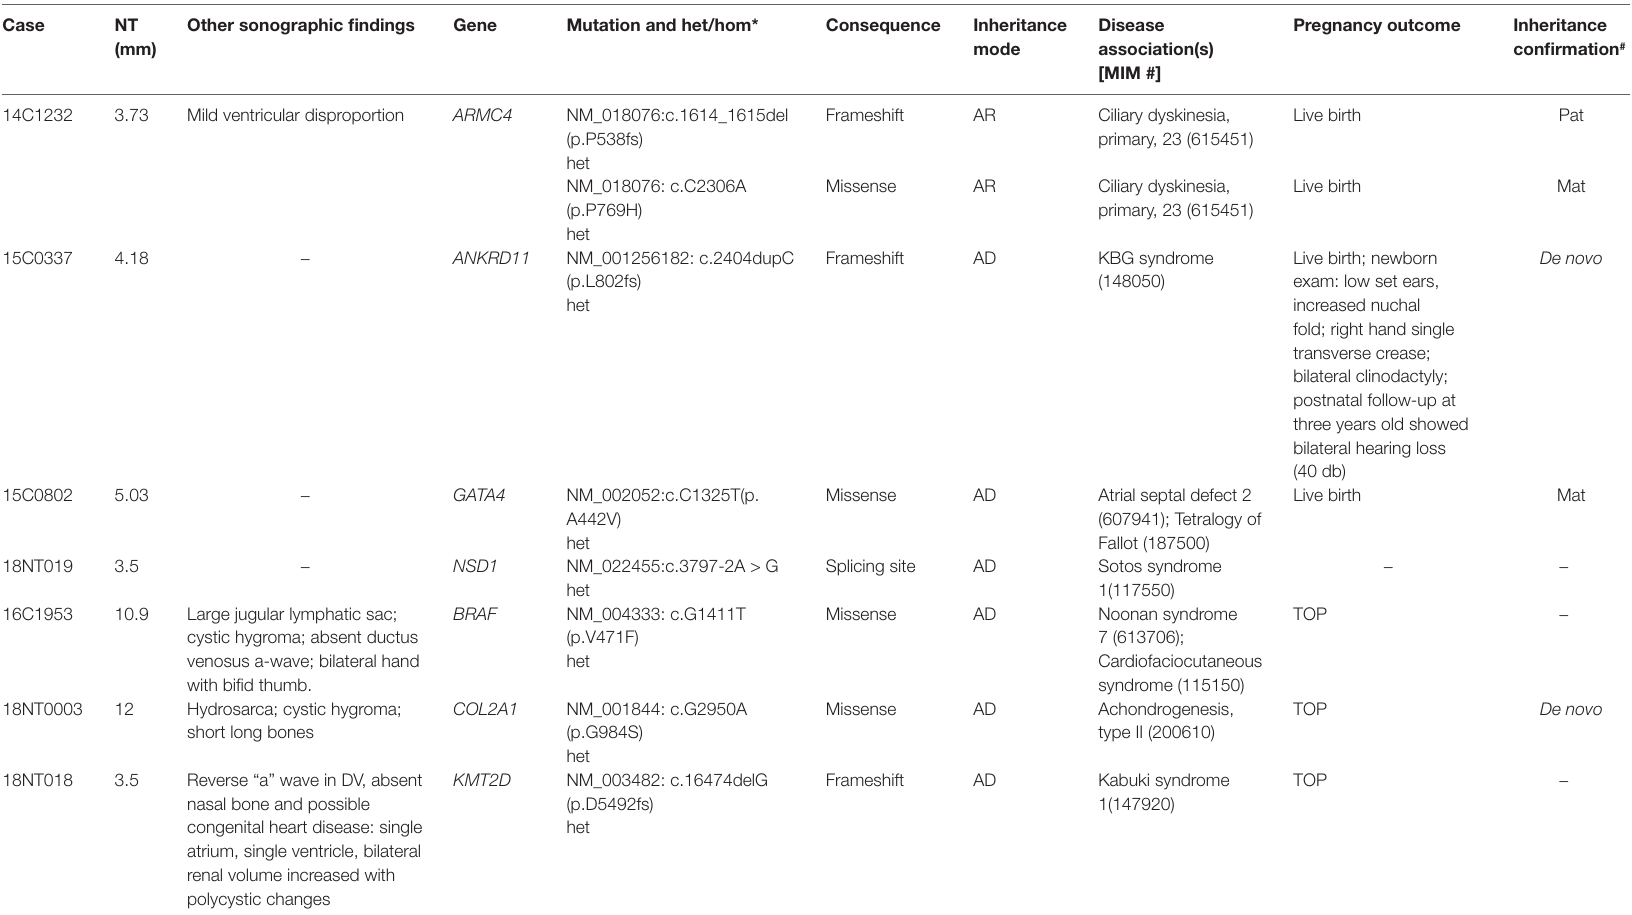
*het/hom refer to heterozygous mutation or homozygous. # Mat and Pat refer to maternally and paternally inherited,